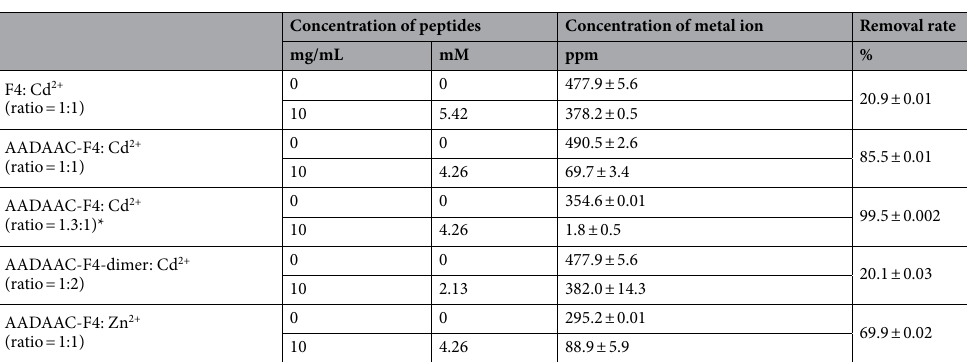
Table 3. The removal rate of metal ions with the peptide treatment. Mean removal rate with SE were shown in the table. Each peptide was dissolved in Tris–HCl buffer solution (50.0 mM Tris, 599 mM NaCl, pH 8.0). The measurements were repeated at least three times. *Small excess amount (1.3-fold) of AADAAC-F4 (10 mg/mL, 4.26 mM) was used to Cd 2+ (3.19 mM, metal: peptide = 1: 1.3 in a ratio).